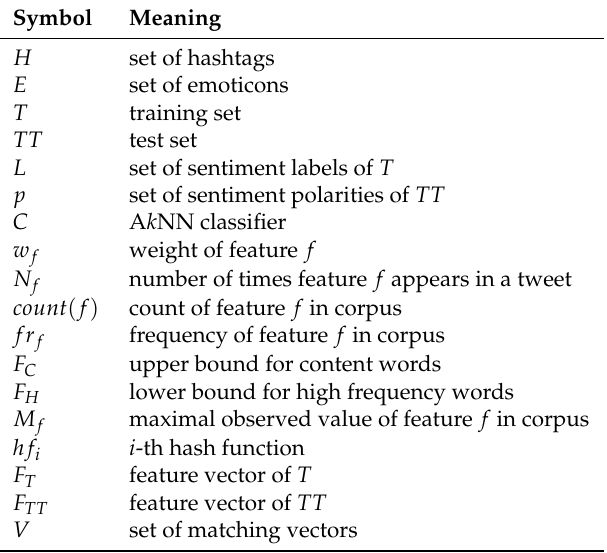
Table 1. Symbols and their